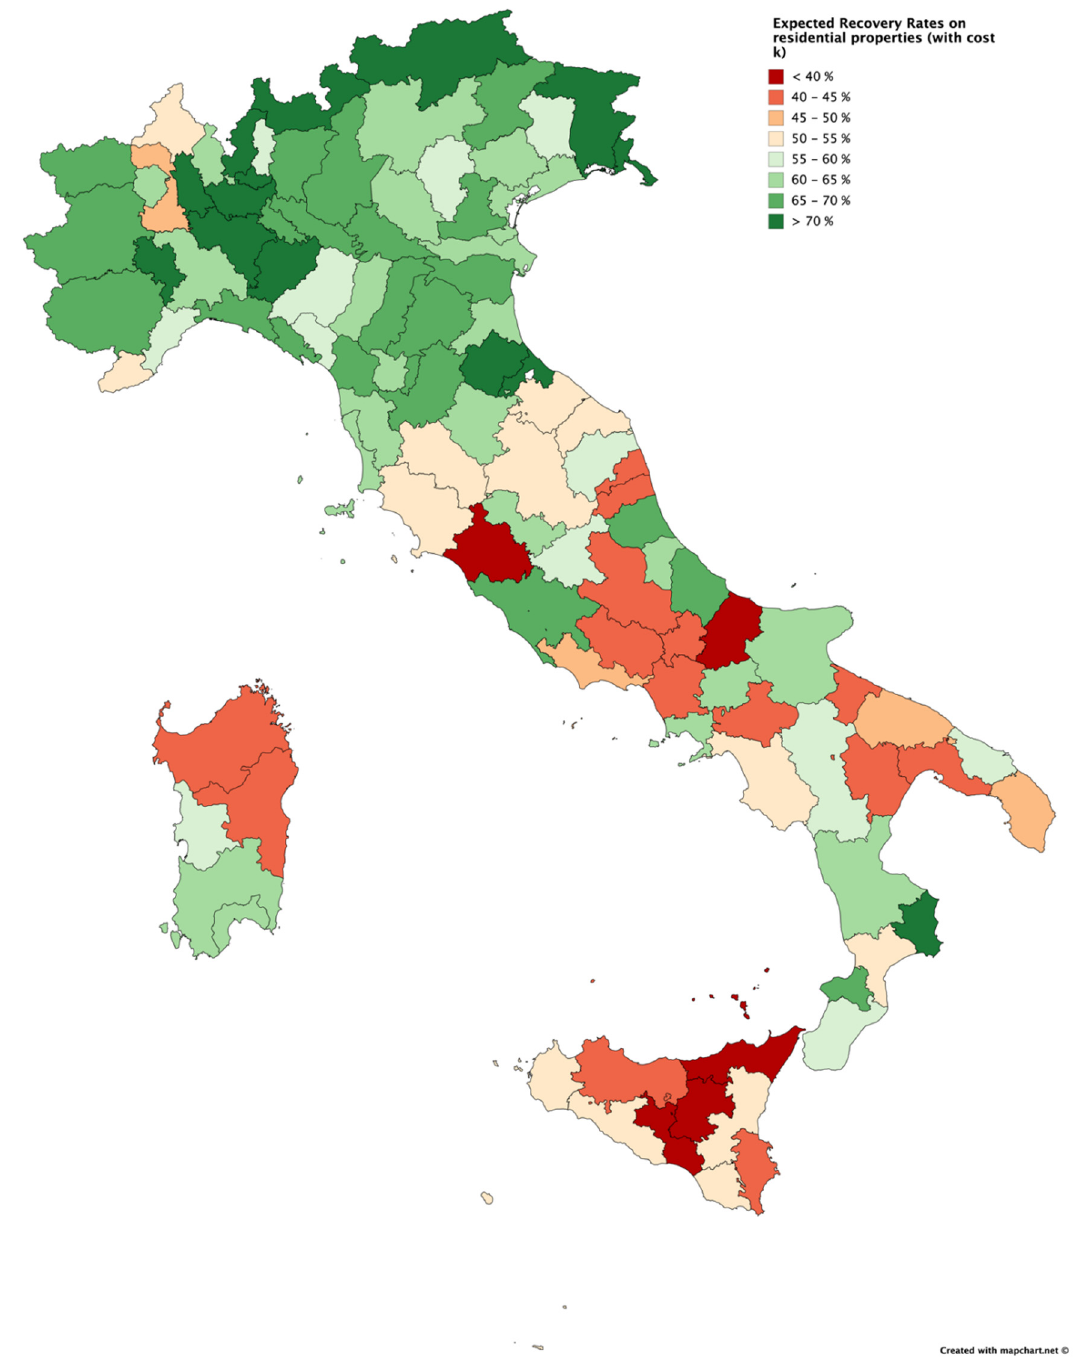
Figure 2. Expected recovery rates for residential properties. (Mapchart.Net 2020). Table 2. Expected recovery rate intervals for residential properties across regions. Expected Recovery Rate Intervals Region